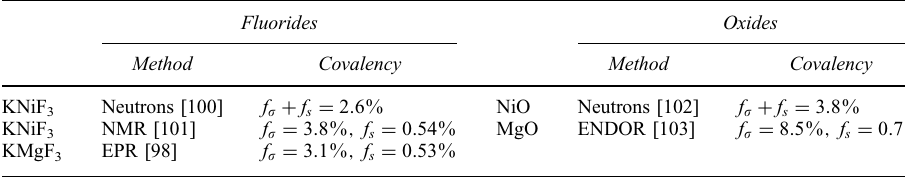
TABLE V (a) Spin Transfer Coefficients for Ni 2 (cid:1)